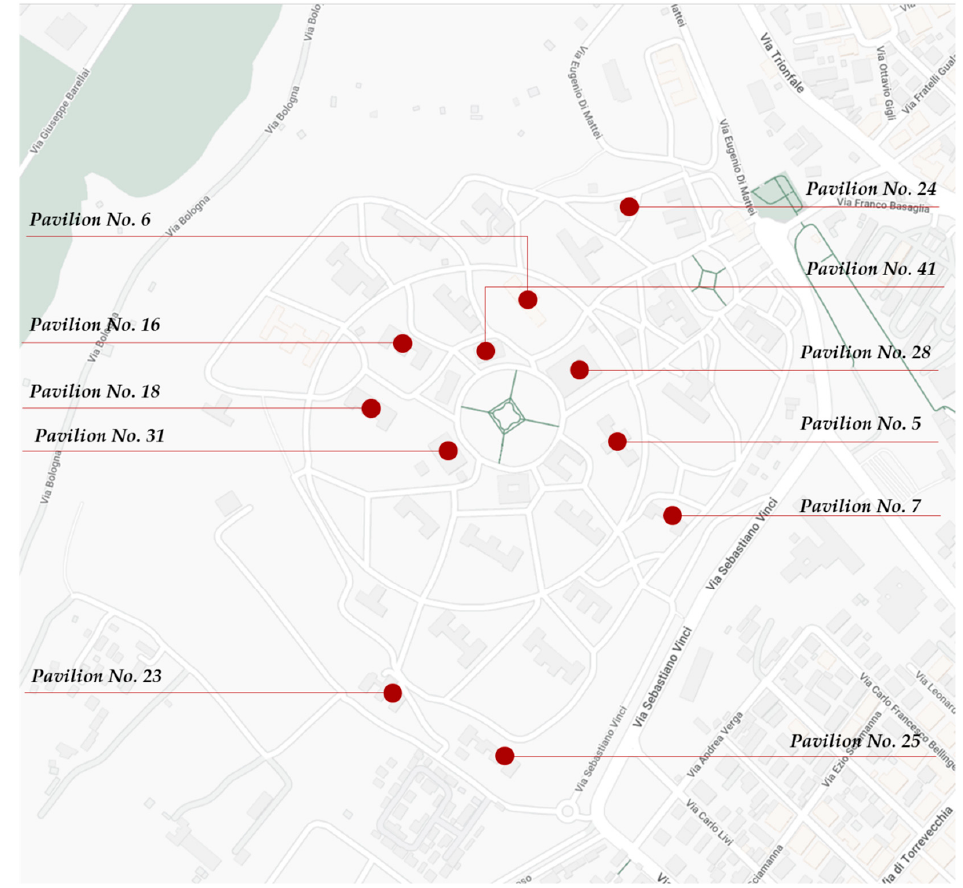
Figure 5. Pavilions of the Santa Maria della Pietà monumental compendium to be transformed.